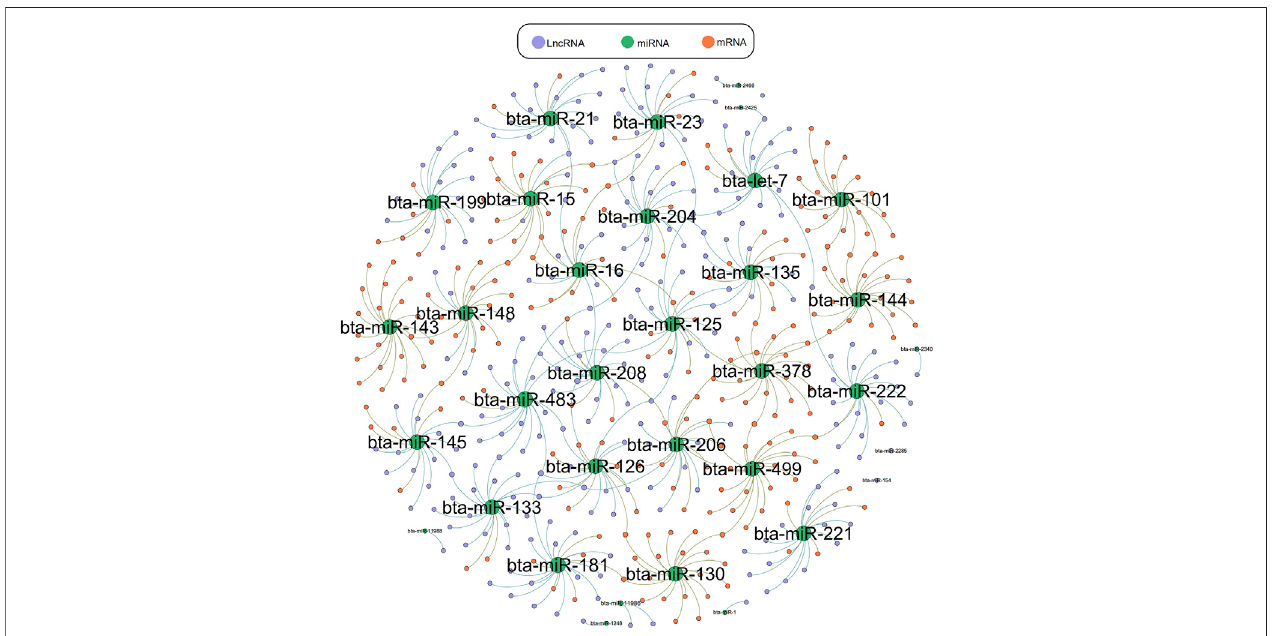
FIGURE 6 | LncRNA-miRNA-mRNA network interaction diagram. LncRNA-miRNA-mRNA interaction network diagram related to muscle, green represents miRNA, orange represents mRNA, purple represents LncRNA.